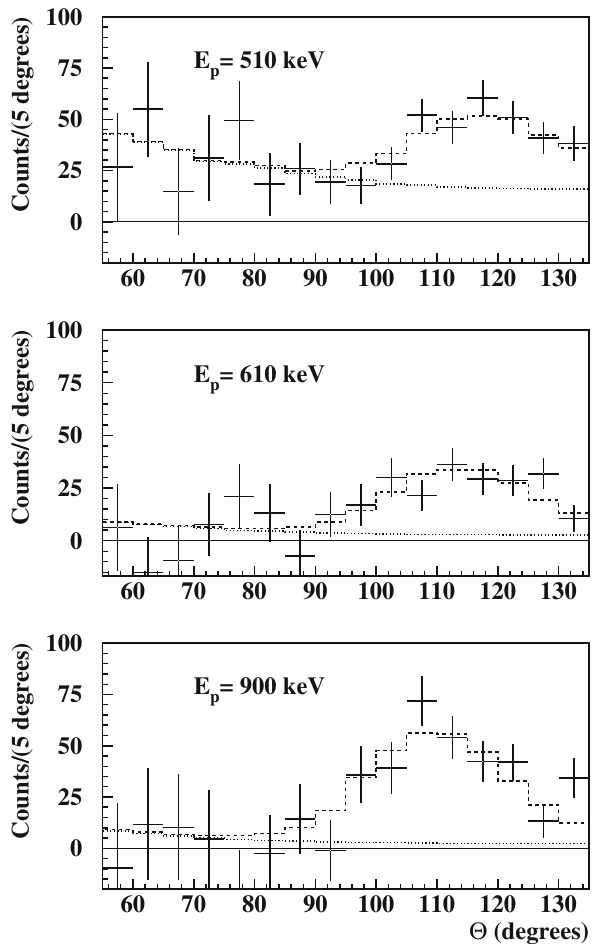
Fig. 5 Comparison of the experimental and the simulated angular cor- relations of the e + e − pairs obtained for 4 He at different proton bom- barding energies as indicated in the figures. The best fit (dashed line) as the sum of the simulated background (dotted line) and the simu- lated contribution of the hypothetical X17 boson is compared with the experimental signal values (dots with error bars)